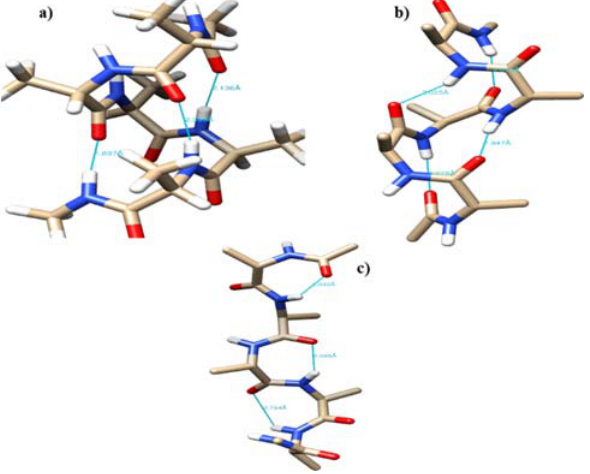
Figure 8. The representative configuration for penta-alanine monomer with ( a ) < ψ > = − 60, ( b ) < ψ >=20, and ( c ) < ψ > = 80.